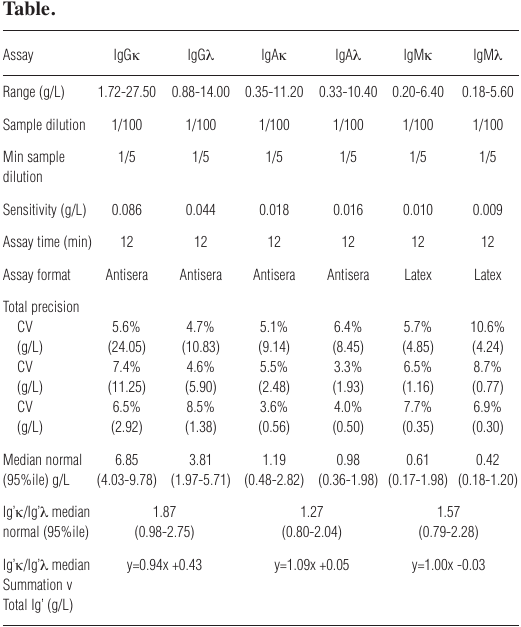
the Dade Behring BN TM II nephelometer. Here we report the use of the IgM(cid:0) and IgM(cid:0) immunoassays for the detec- tion and the quantification of IgM monoclonal protein in patients with Waldenstrom’s Macroglobulinemia (WM) and monoclonal gammopathy of undetermined signifi- cance (MGUS). Methods. IgM k and IgM λ assay charac- teristics are summarized in the table below. Normal ran- ges for IgM k and IgM λ were derived from 89 normal (blood donor) sera and summated values compared with total IgM (Siemens Dade Behring BNII). IgM k and IgM λ concentrations were measured in 19 IgM WM (14 IgM k and 5 IgM λ ) and 4 MGUS (4 IgM k ) patients. Results. Normal range results were; median IgM k 0.611g/L (range